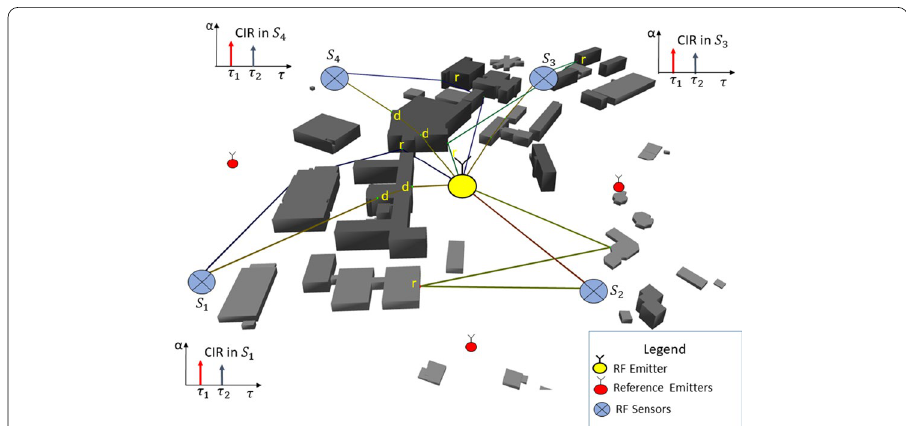
Fig. 3 Extraction of CIR fingerprints using ray